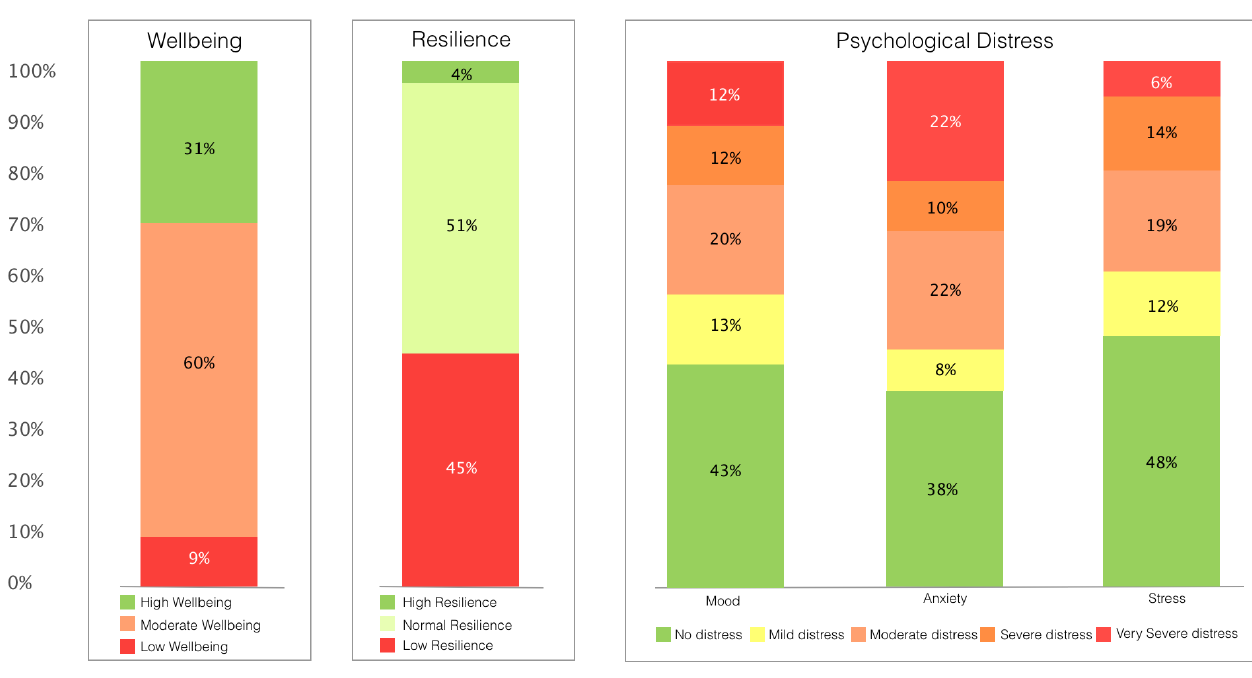
Proportions of students displayed per cut-off for wellbeing (left graph), resilience (middle graph) and psychological distress (right graphs